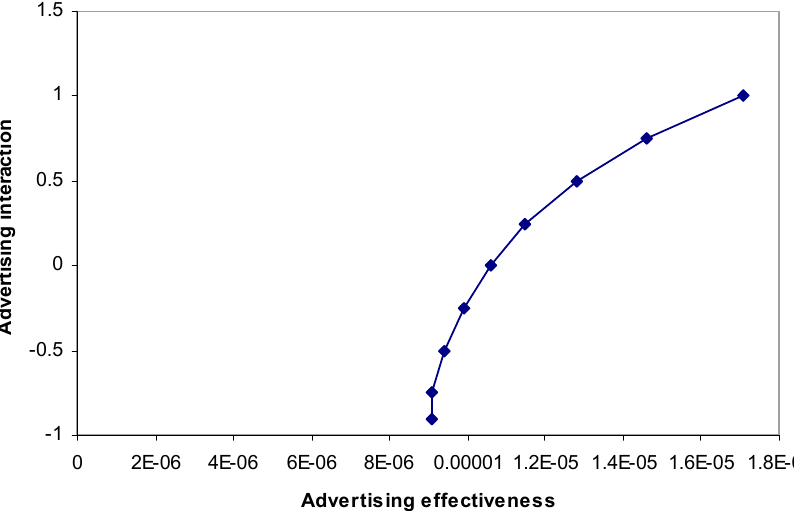
Figure 9. Advertising interaction versus advertising effectiveness under symmetric advertising.